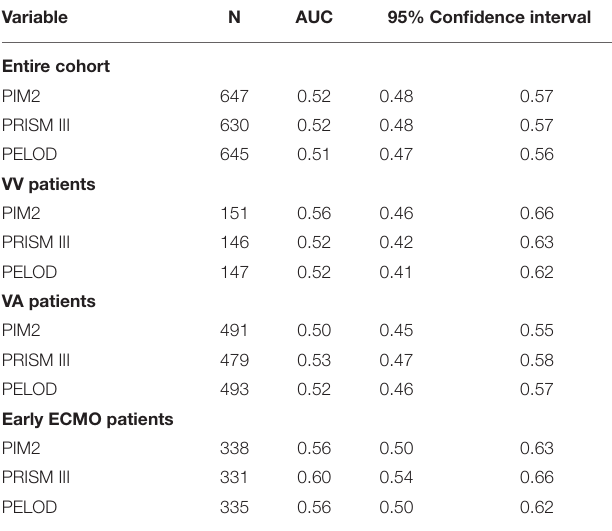
TABLE 4 | Area under the curve (AUC) for severity of illness scores predicting mortality. Variable N